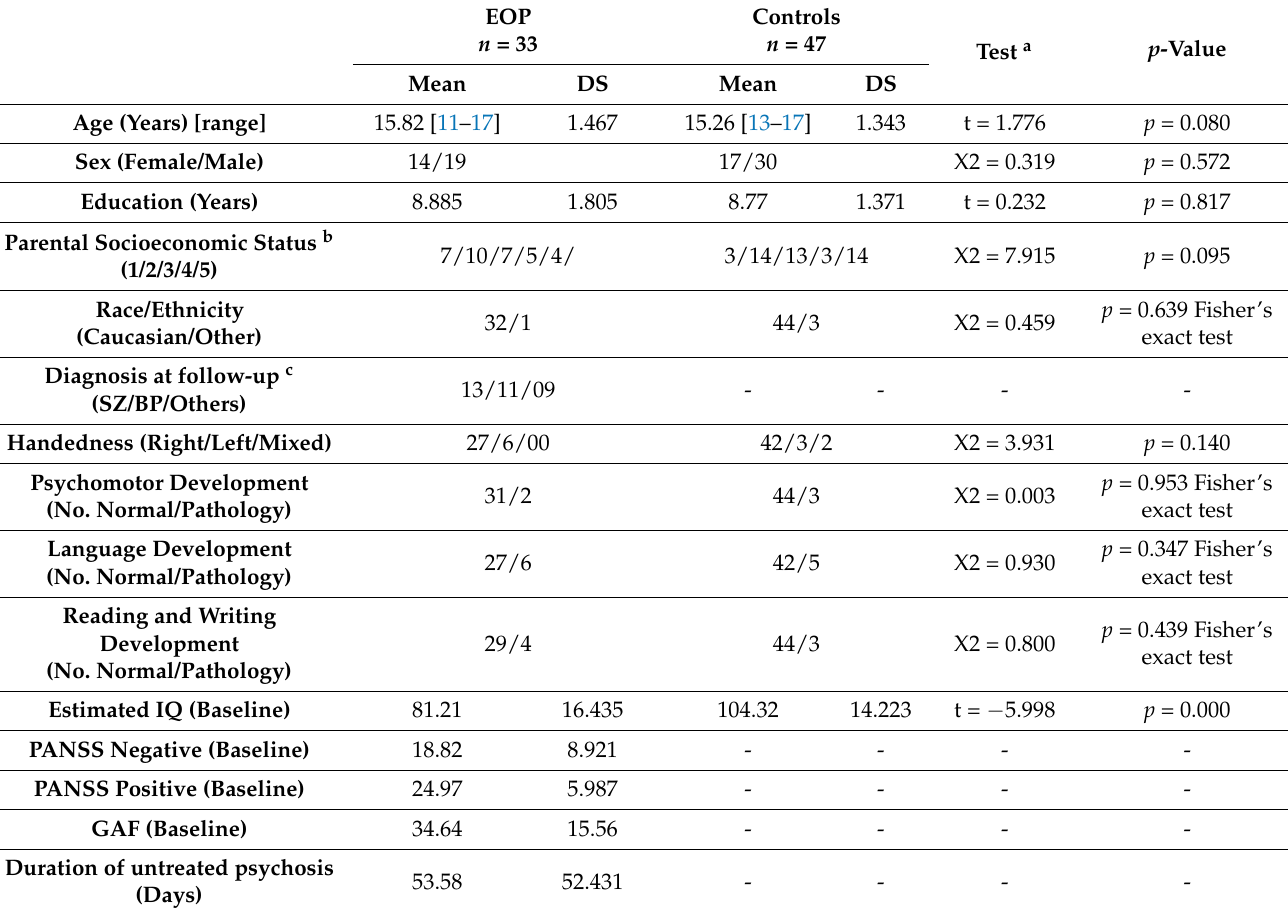
Table 2. Sociodemographic and clinical characteristics of EOP individuals and controls. EOP